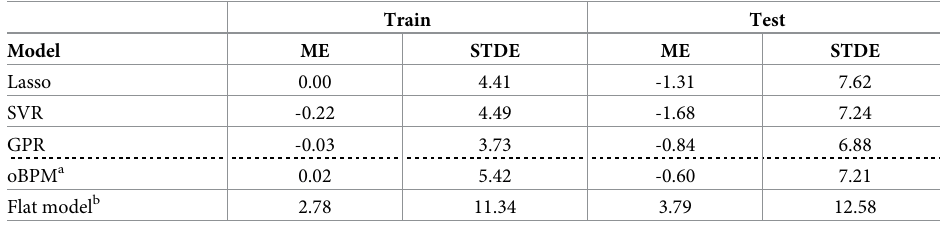
Table 4. DBP estimation performance in